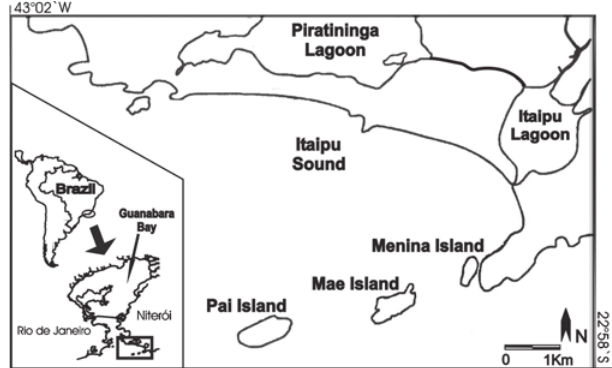
Fig. 1. Map of Itaipu Sound, showing the three study sites: Menina, Mãe and Pai Islands. Inset represents the geographi- cal location of Itaipu Sound in relation to Guanabara Bay and the Rio de Janeiro coast within